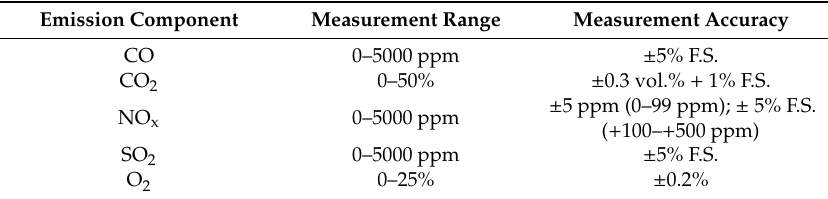
Table 4. Measurement range and resolution of TESTO 350M analyser.